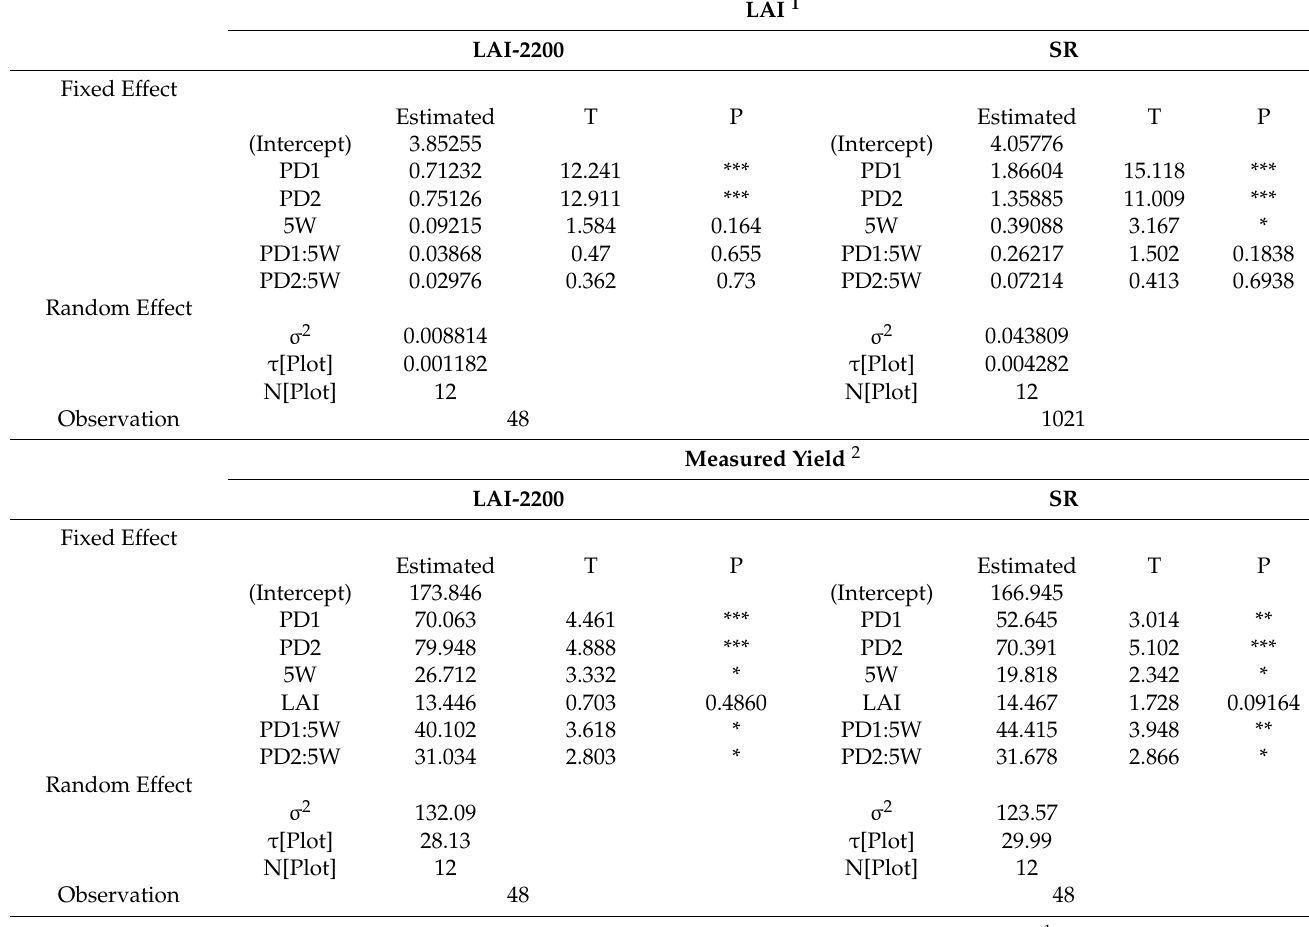
Table 3. Linear mixed model analysis of the LAI and measured yield in